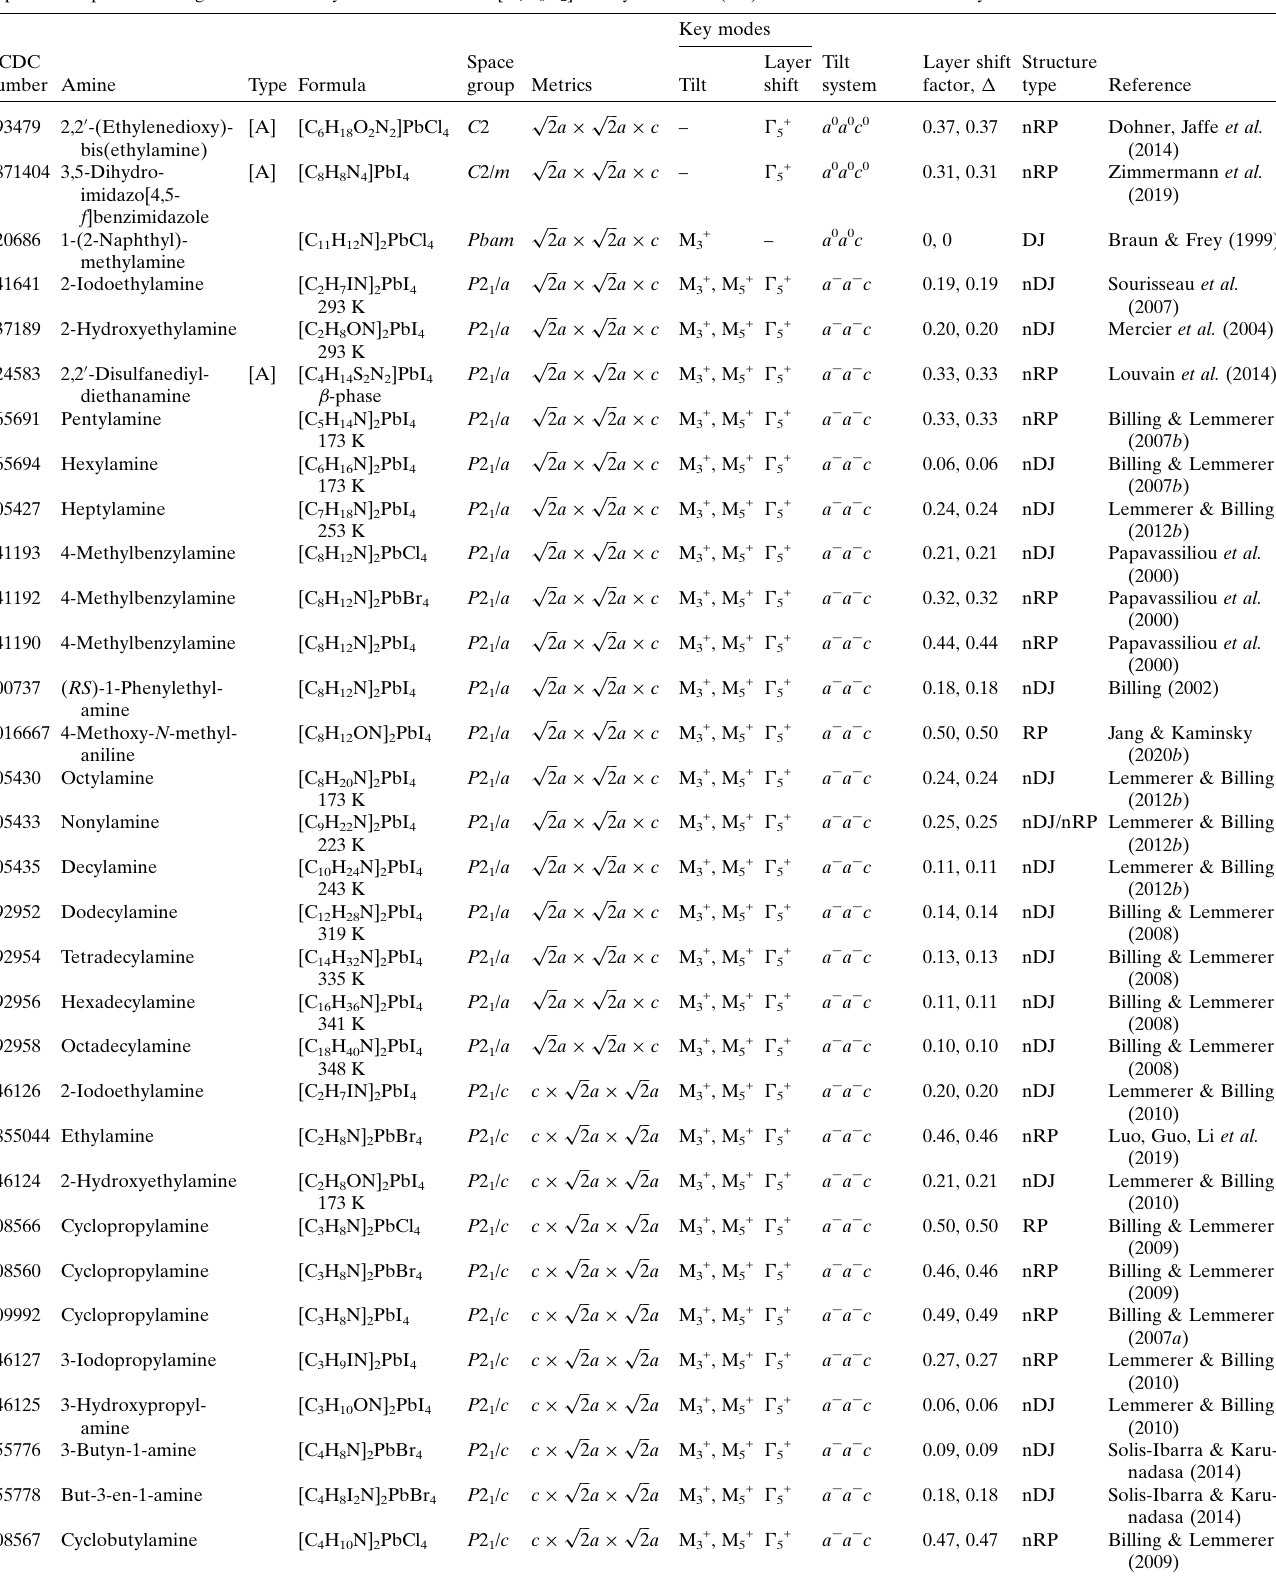
Table 4 Summary of experimentally known structures with one octahedral layer per unit cell (derived from DJ parent, P 4/ mmm ). Separate tilt patterns are given for both layers when relevant. [C 4 H 6 O 2 ] = dihydrofuran-2(3 H )-one is solvated into the crystal